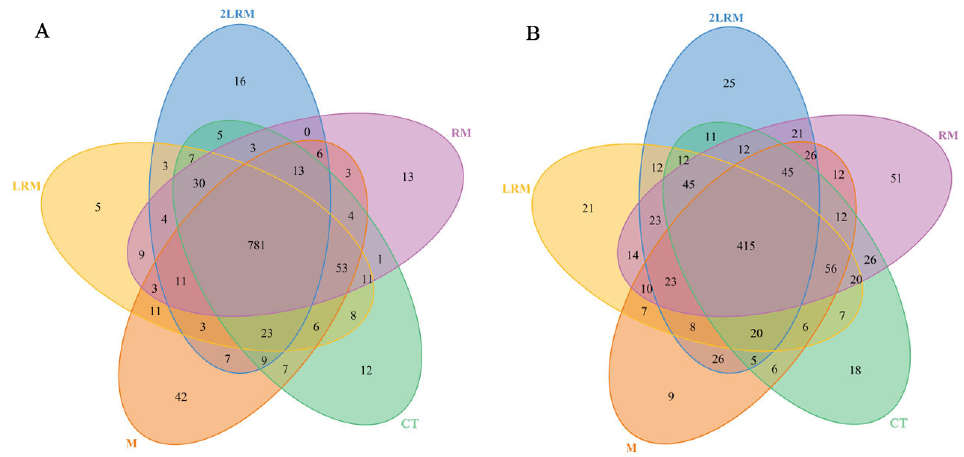
Figure 1. Venn diagram of soil bacteria ( A ) and fungi ( B ) in different treatments.